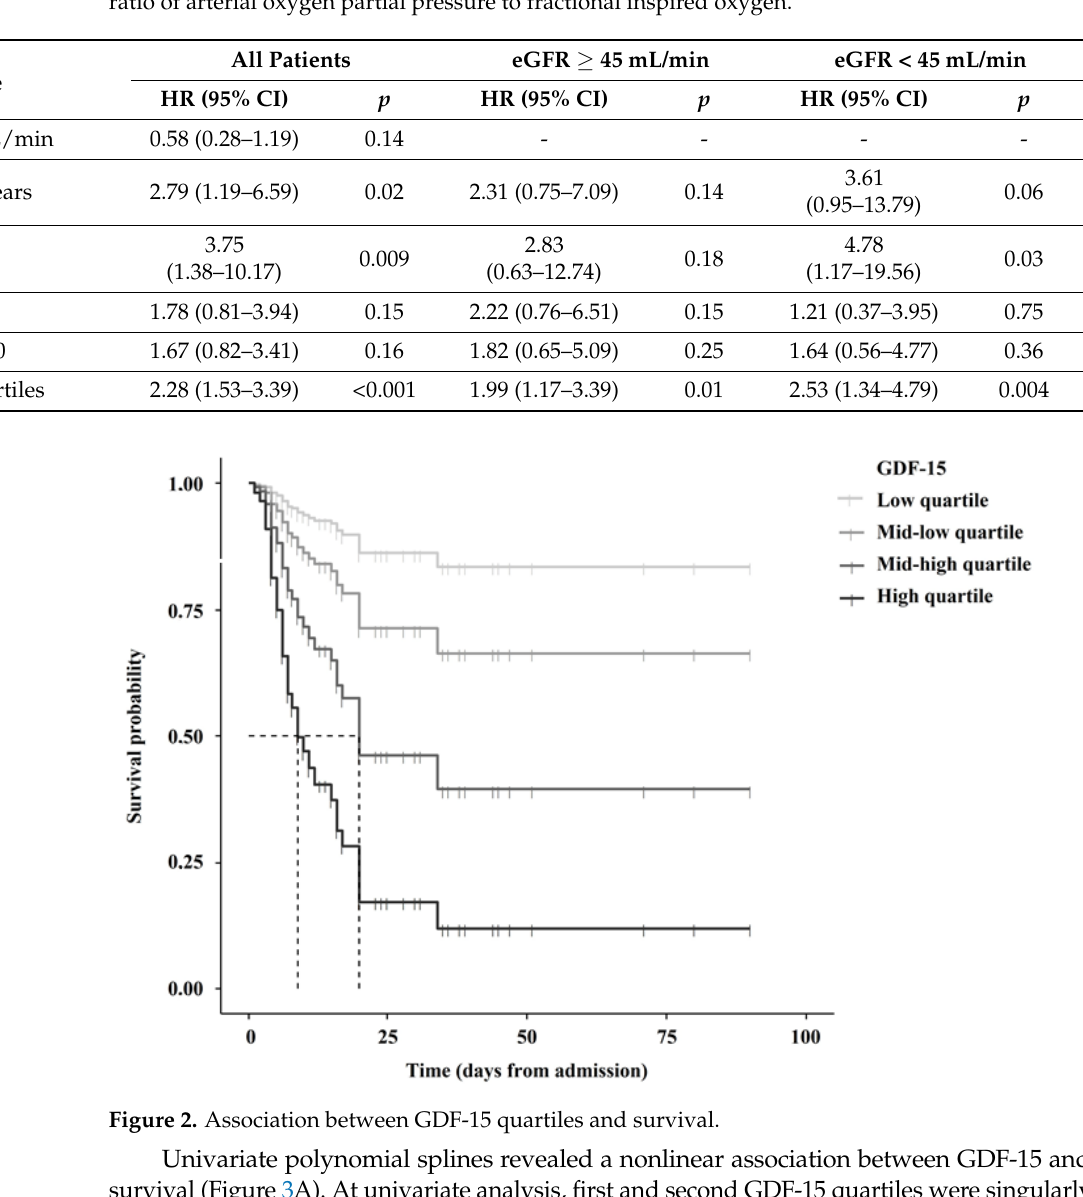
Table 2. Multivariate Cox regression model for survival in all patients, stratified by eGFR. Abbrevia- tions: eGFR, estimated glomerular filtration rate; GDF-15, growth and differentiation factor 15; P/F, ratio of arterial oxygen partial pressure to fractional inspired oxygen.